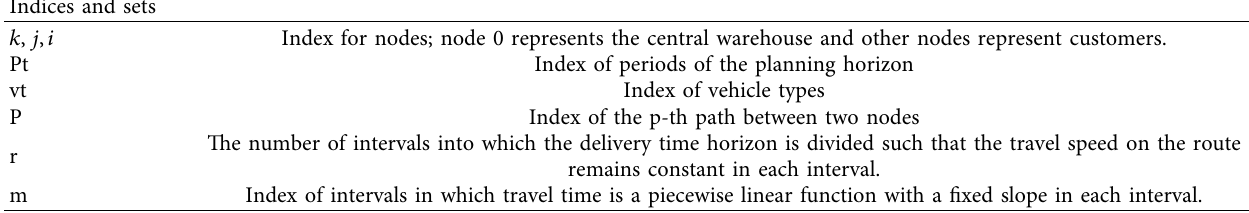
Table 1: Indices, variables, and parameters of the proposed